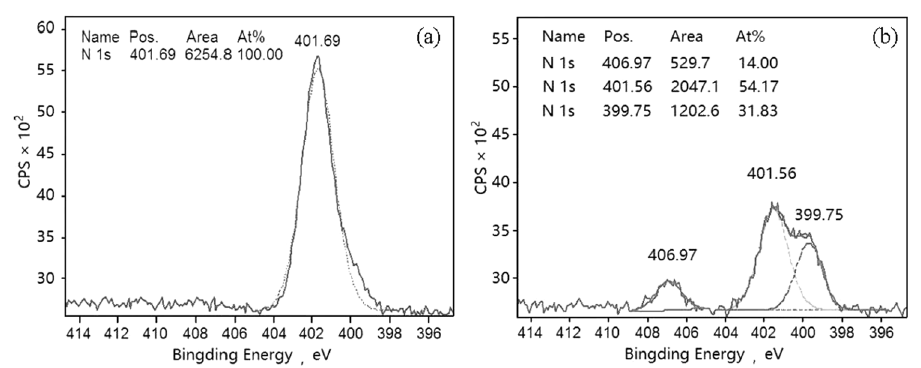
Figure 2. XPS N1s spectra of 20 wt.% (NH 4 ) 2 SO 4 -TiO 2 . ( a ) Before photoreaction with formaldehyde. ( b ) After the photoreaction with